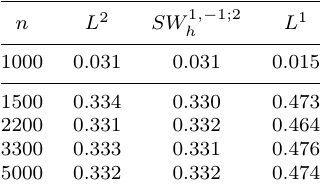
Table 10. Practical errors and error orders in Example B − 1 / 2